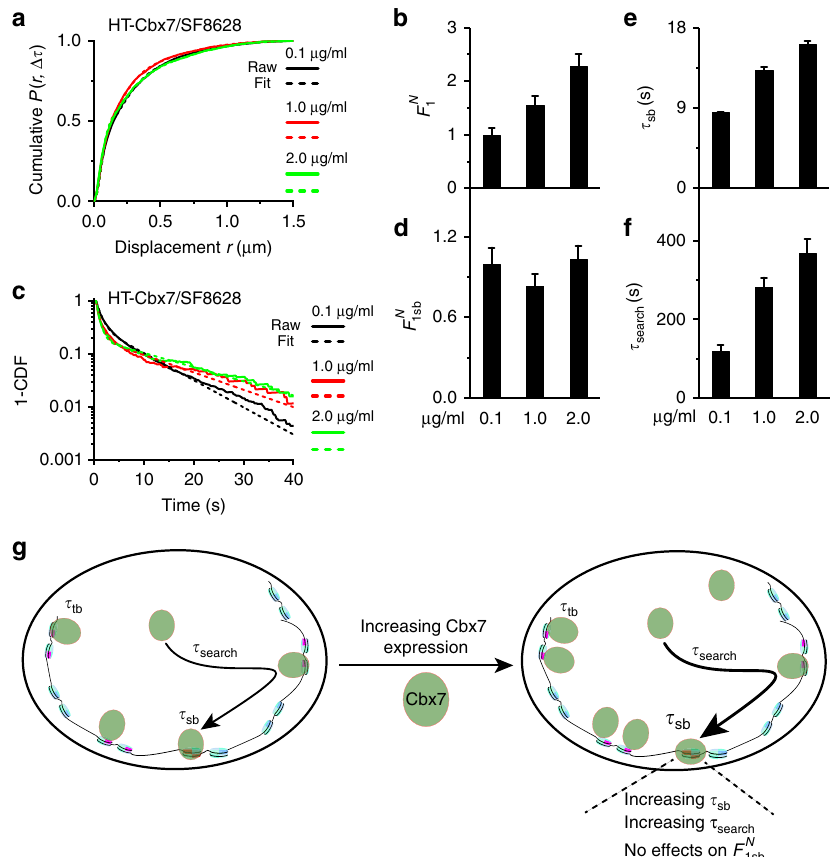
Fig. 8 Elevating Cbx7 levels increases its stability on chromatin. a Cumulative distribution of displacements for HaloTag-Cbx7 in SF8628 cells administrated with 0.1 µ g per ml doxycycline replicated from Fig. 4, 1.0 µ g per ml ( N = 47 cells, n = 7102 displacements), and 2.0 µ g per ml ( N = 38 cells, n = 3543 displacements) doxycycline. The cumulative distributions were fi tted with three populations. Fitted parameters are shown in Supplementary Þ . Unless otherwise indicated, the superscript N represents that a given value was normalized by the Table 9. b Normalized chromatin-bound population ð F N 1 Cbx7 level obtained from the immunostaining of Cbx7 (Fig. 7b) and by the chromatin-bound level at 0.1 µ g per ml doxycycline. Results are means ± SD. c Survival probability distribution of the dwell times for HaloTag-Cbx7 in SF8628 cells administrated with 0.1 µ g per ml doxycycline replicated from Fig. 5, 1.0 µ g per ml ( N = 49 cells, n = 725 trajectories), and 2.0 µ g per ml ( N = 64 cells, n = 907 trajectories) doxycycline. The distributions were fi tted with a two- component exponential decay model. Fitted parameters are shown in Supplementary Table 10. d – f Normalized long-lived fraction ( F N ) ( d ), residence time 1 sb ( e ), and search time ( f ) of the long-lived HaloTag-Cbx7 population. Results are means± SD from three biological replicates. g A proposed mechanism that underpins how increasing Cbx7 levels in fl uences the binding and target search mechanism. Our data indicate that increasing Cbx7 levels has no effect on the number of Cbx7 molecules on the speci fi c sites, however, increases its level bound to the non-speci fi c sites. The residence time of Cbx7 molecules on the speci fi c sites increases upon increasing Cbx7 levels. Increasing Cbx7 levels increases its search time, which is primarily due to the fact that Cbx7